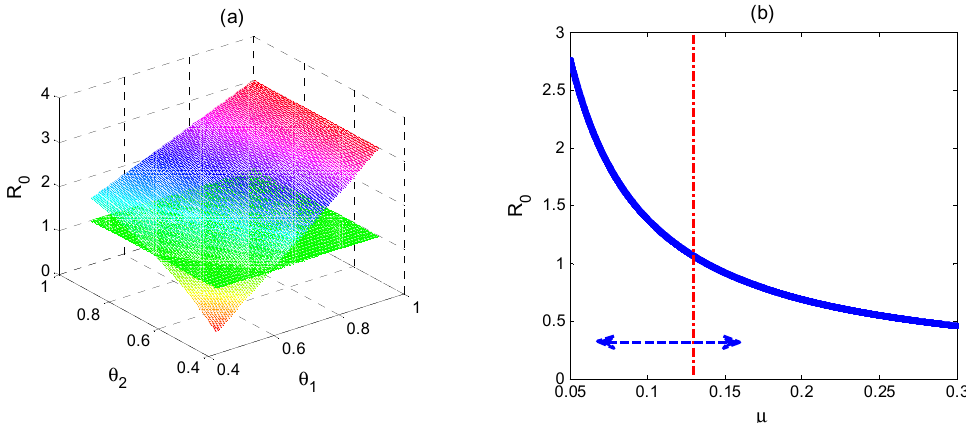
Figure 5. ( a ) The tendency of information spreading considering spread velocity; ( b ) Information spreading under the forget mechanism.